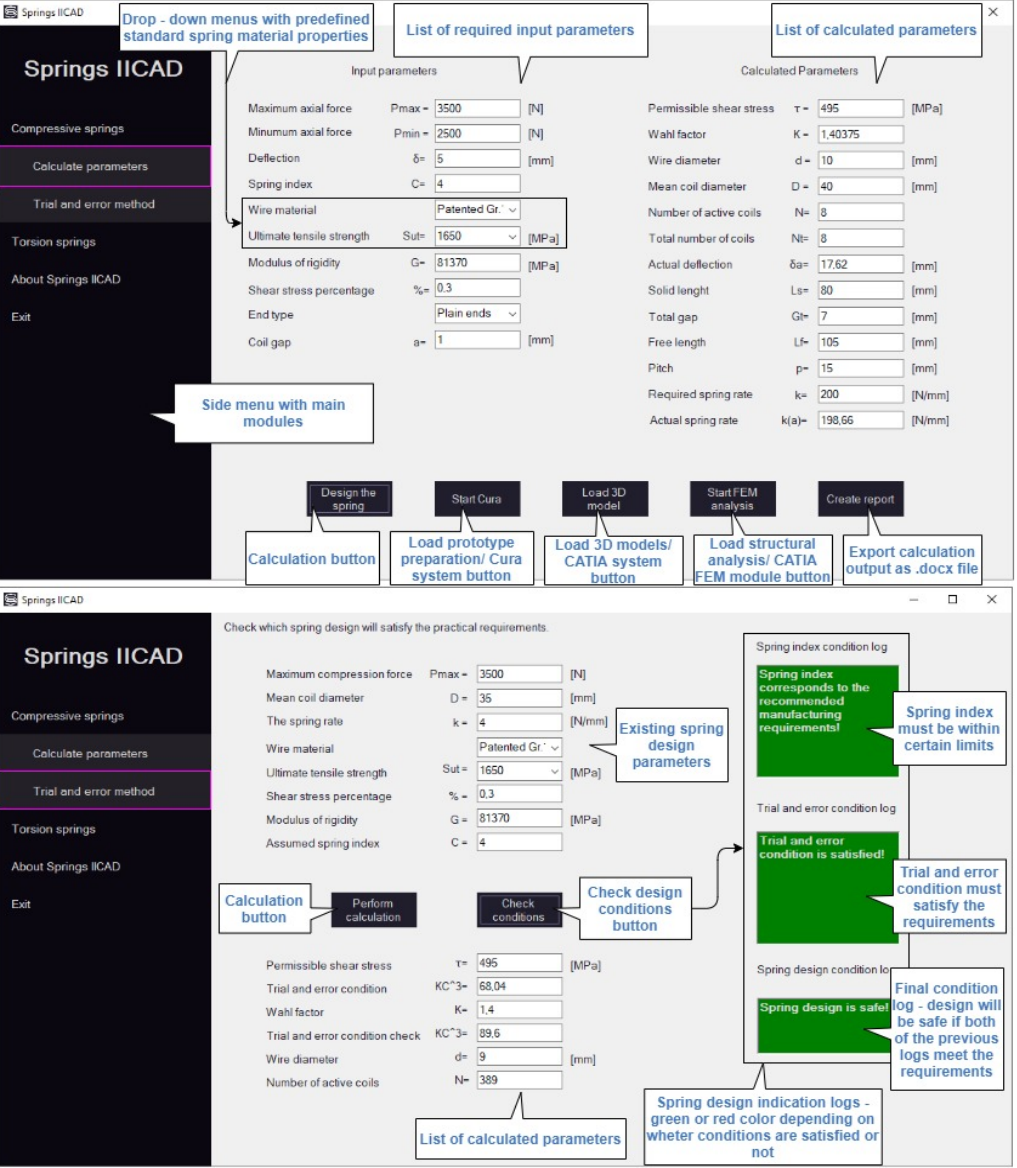
Figure 3. Interface layout of the Springs IICAD system (top to bottom: computation module and trial and error method module, respectively).